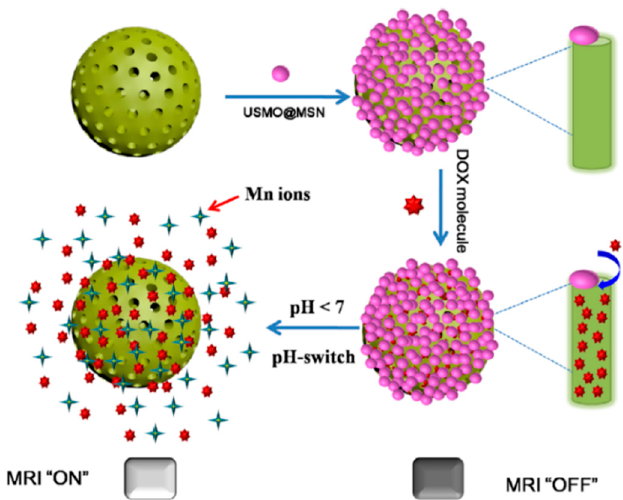
Figure 3. Mechanism of drug release and MRI contrast enhancement of MSN@USMO by dissolution of manganese nanoparticles in mild acidic conditions. Reproduced with permission from [65], American Chemical Society, 2018.